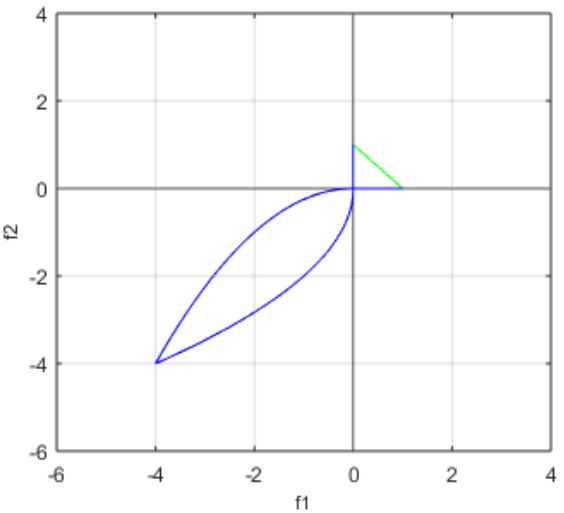
Figure 2. Payoff space of the game G 0